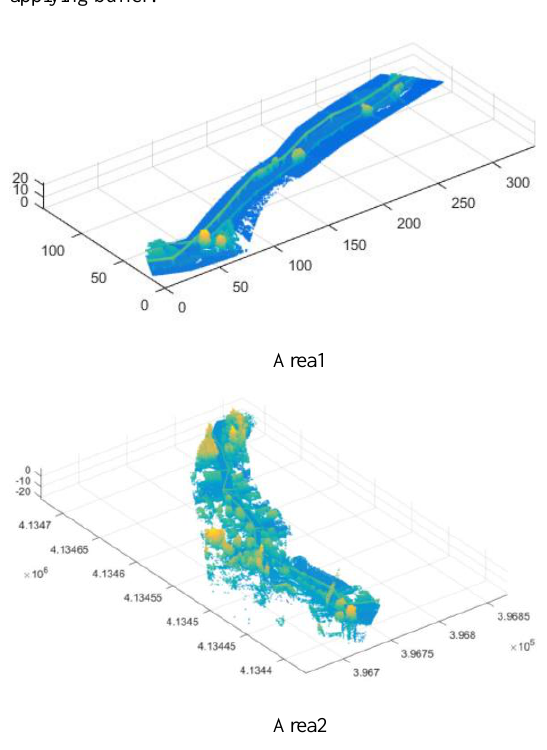
Figure 3. Test area before and after filtering using 25m buffer.